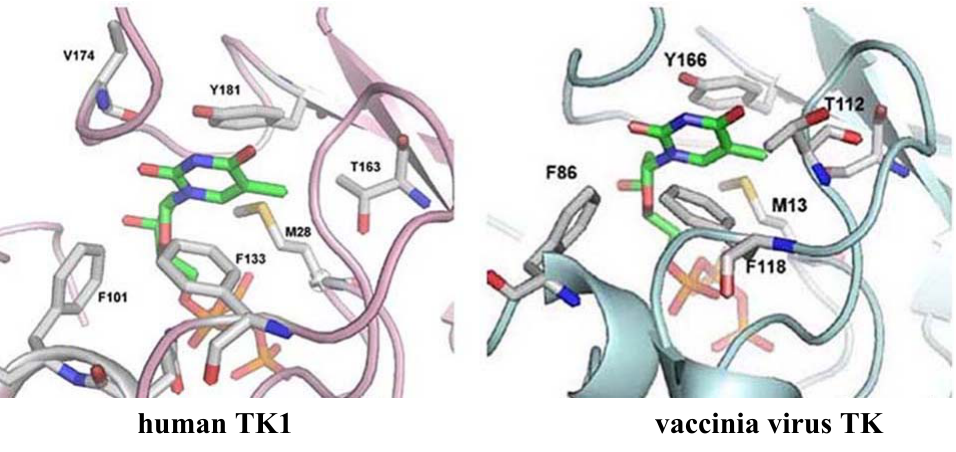
Figure 2. Structure of the active sites of human TK1 (left) and vaccinia virus TK (right). Both the human and vaccinia virus enzymes co-purified with the allosteric effector, dTTP, which was resolved in the published three–dimensional structures of the enzymes.